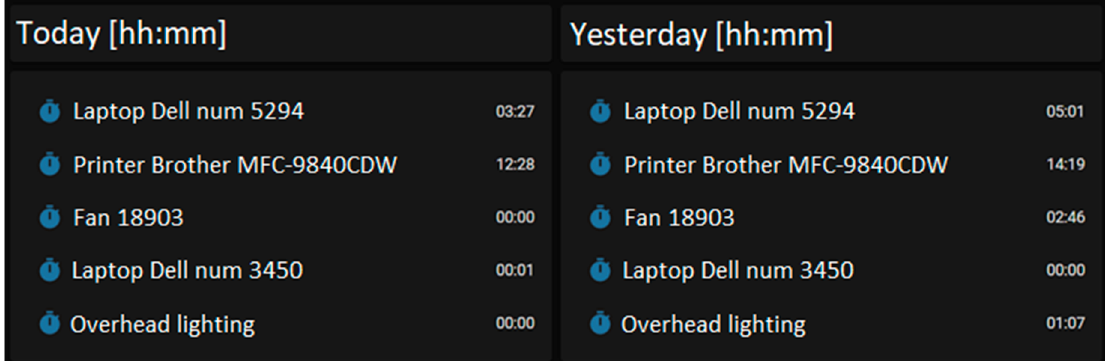
Figure 16. Graphic panels designed by CBRTI Sp. z o.o. Research and Development Center presenting the total operating times of selected electrical devices located in the building.